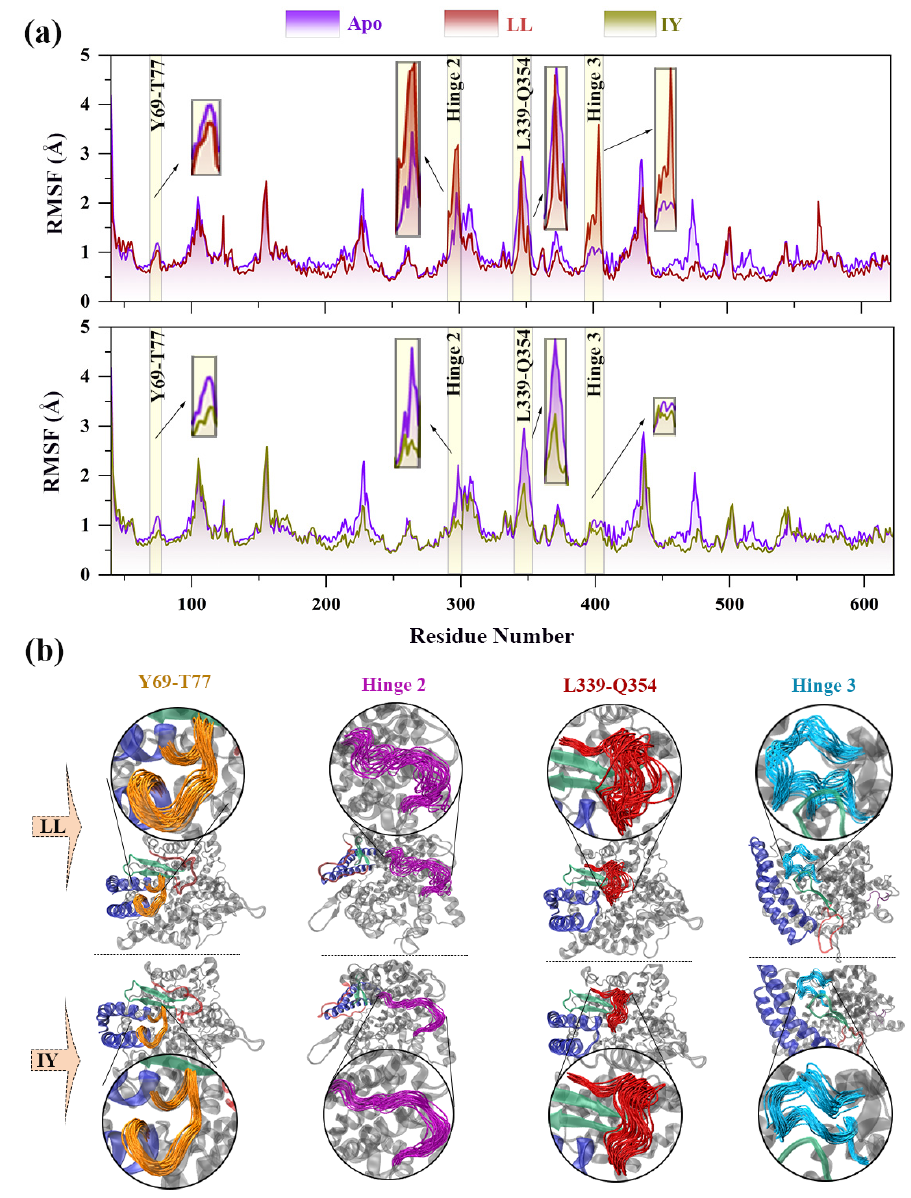
Figure 3. ( a ) RMSFs of C α atoms in the three systems, and critical regions are highlighted with rectangles. RMSF is root mean square fluctuation; ( b ) superposition of extracted protein conformations from MD (molecular dynamics) trajectories for critical regions. The Apo means ligand-free protein, LL represents the complex system of protein and dipeptide Leu-Leu, and IY stands for complex system of protein and dipeptide Ile-Tyr.